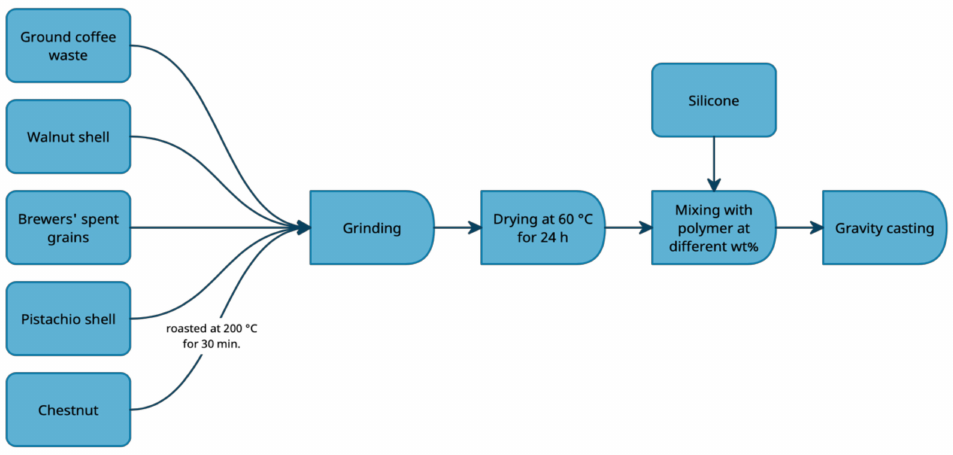
Figure 1. Material preparation